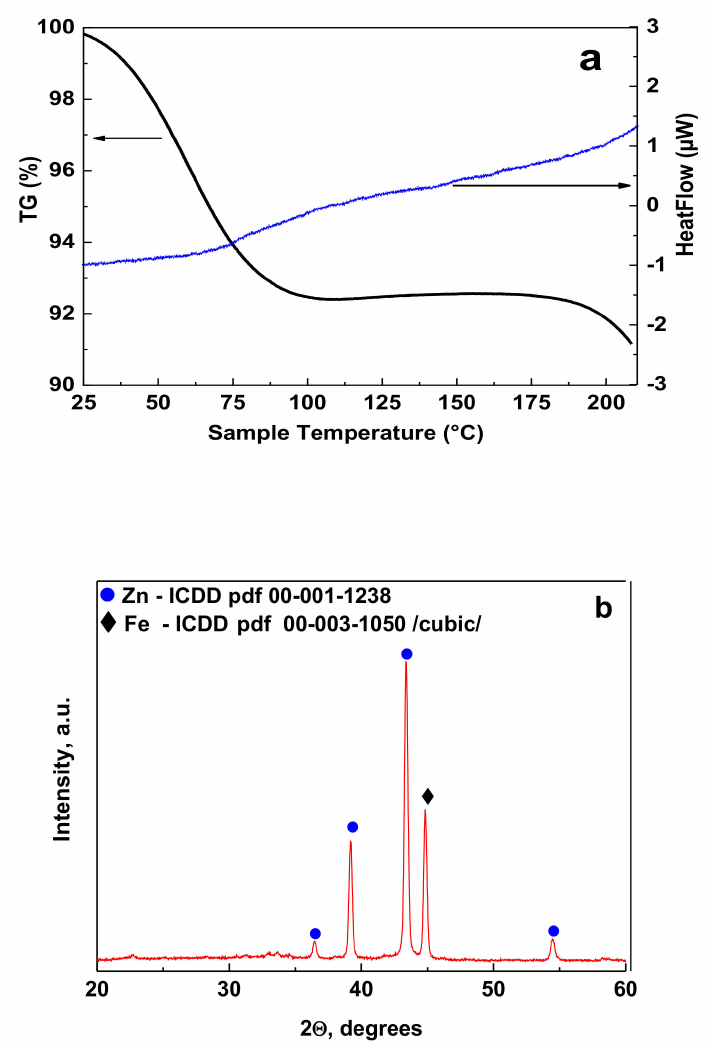
Figure 1. DTA/TG curves of the dried precursor mixtures ( a ) and XRD pattern of the “sandwich” multilayer coating structure ( b